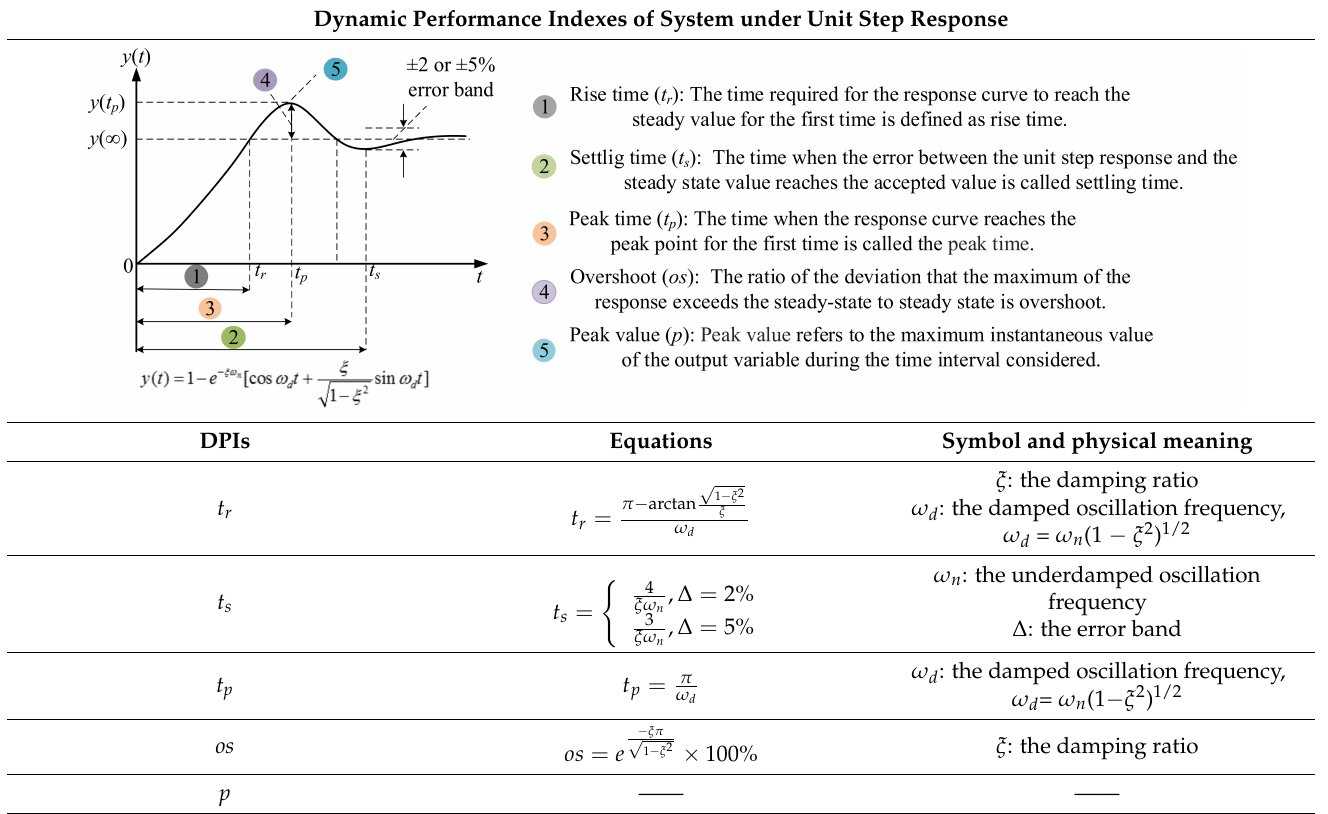
Table A1. Dynamic performance indexes of system under unit step response.